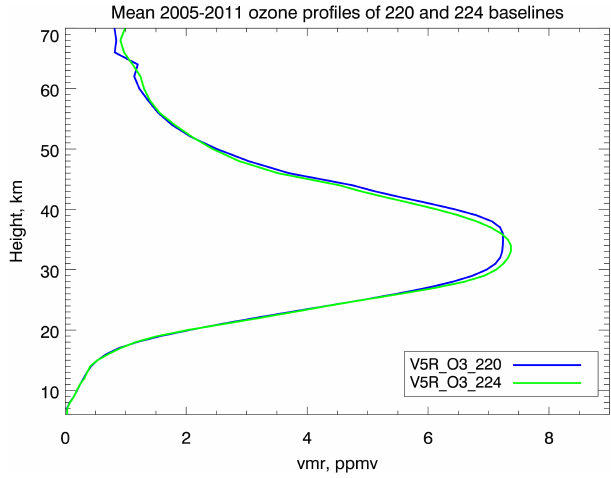
Figure 1. Mean ozone profiles of versions V5R_O3_220 and